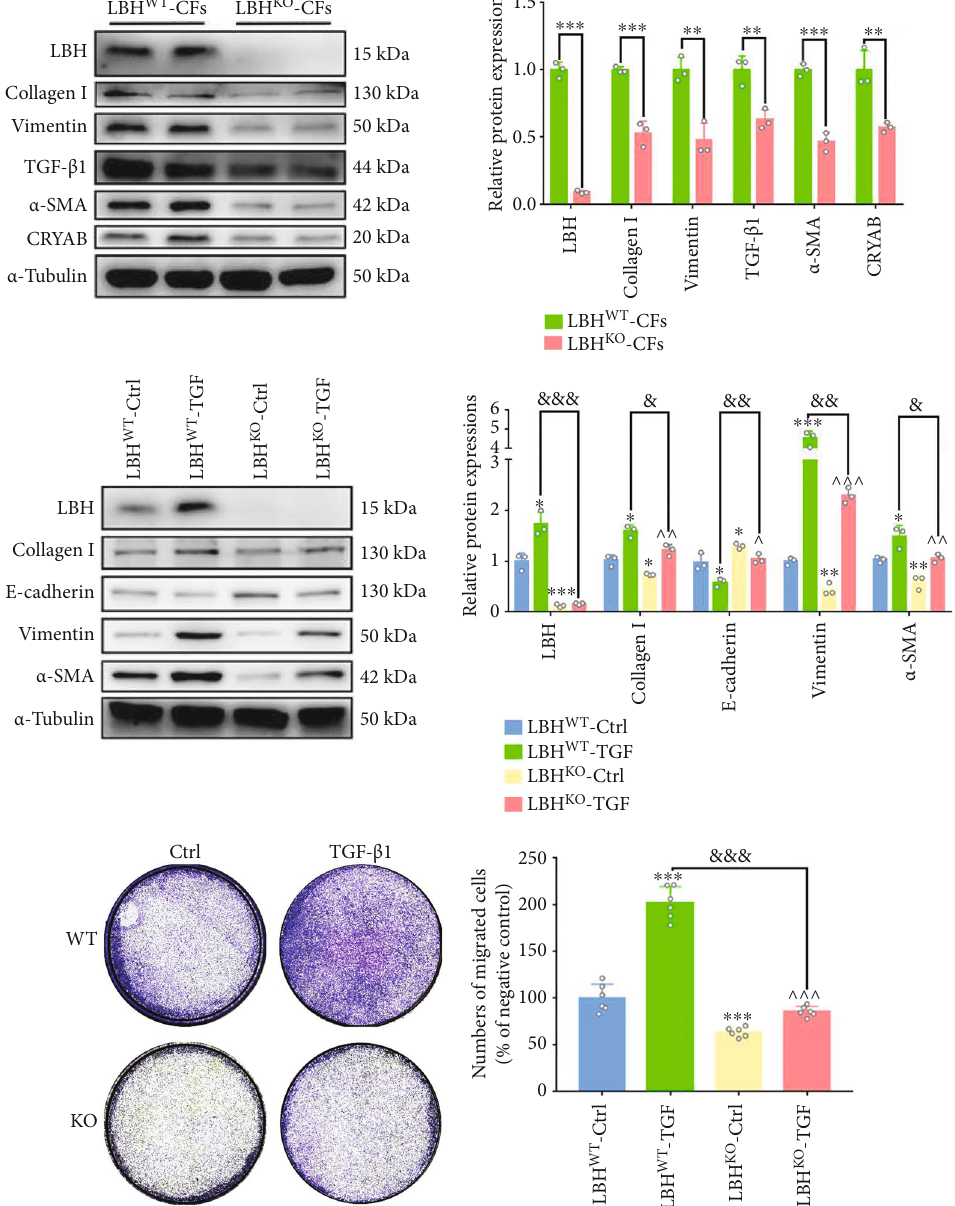
Figure 5: CFs isolated from LBH KO mice showed partially mitigated CF activation under TGF- β stimulation. (a) Protein levels of LBH, CRYAB, collagen I, α -SMA, E-cadherin, vimentin, and TGF- β 1 in CFs isolated from LBH WT and LBH KO mice ( ∗∗ p < 0 : 01 and ∗∗∗ p < 0 : 001 vs. LBH WT ). (b) Protein levels of LBH, collagen I, α -SMA, E-cadherin, and vimentin in both LBH WT and LBH KO mouse CFs under TGF- β stimulation ( ∗ p < 0 : 05 , ∗∗ p < 0 : 01 , and ∗∗∗ p < 0 : 001 vs. LBH WT -Ctrl; ∧ p < 0 : 05 , ∧∧ p < 0 : 01 , and ∧∧∧ p < 0 : 001 vs. LBH KO - Ctrl; & p < 0 : 05 , && p < 0 : 01 , and &&& p < 0 : 001 vs. LBH WT -TGF). (c) Representative images of the Transwell assay of LBH WT and LBH KO mouse CFs under TGF- β stimulation and the corresponding statistical analysis ( ∗∗∗ p < 0 : 001 vs. LBH WT -Ctrl; ∧∧∧ p < 0 : 001 vs. LBH KO - Ctrl; &&& p < 0 : 001 vs. LBH WT